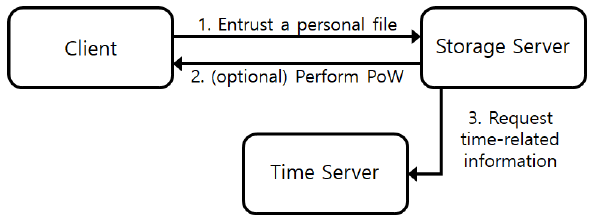
Figure 2. Time-based Locked Deduplication